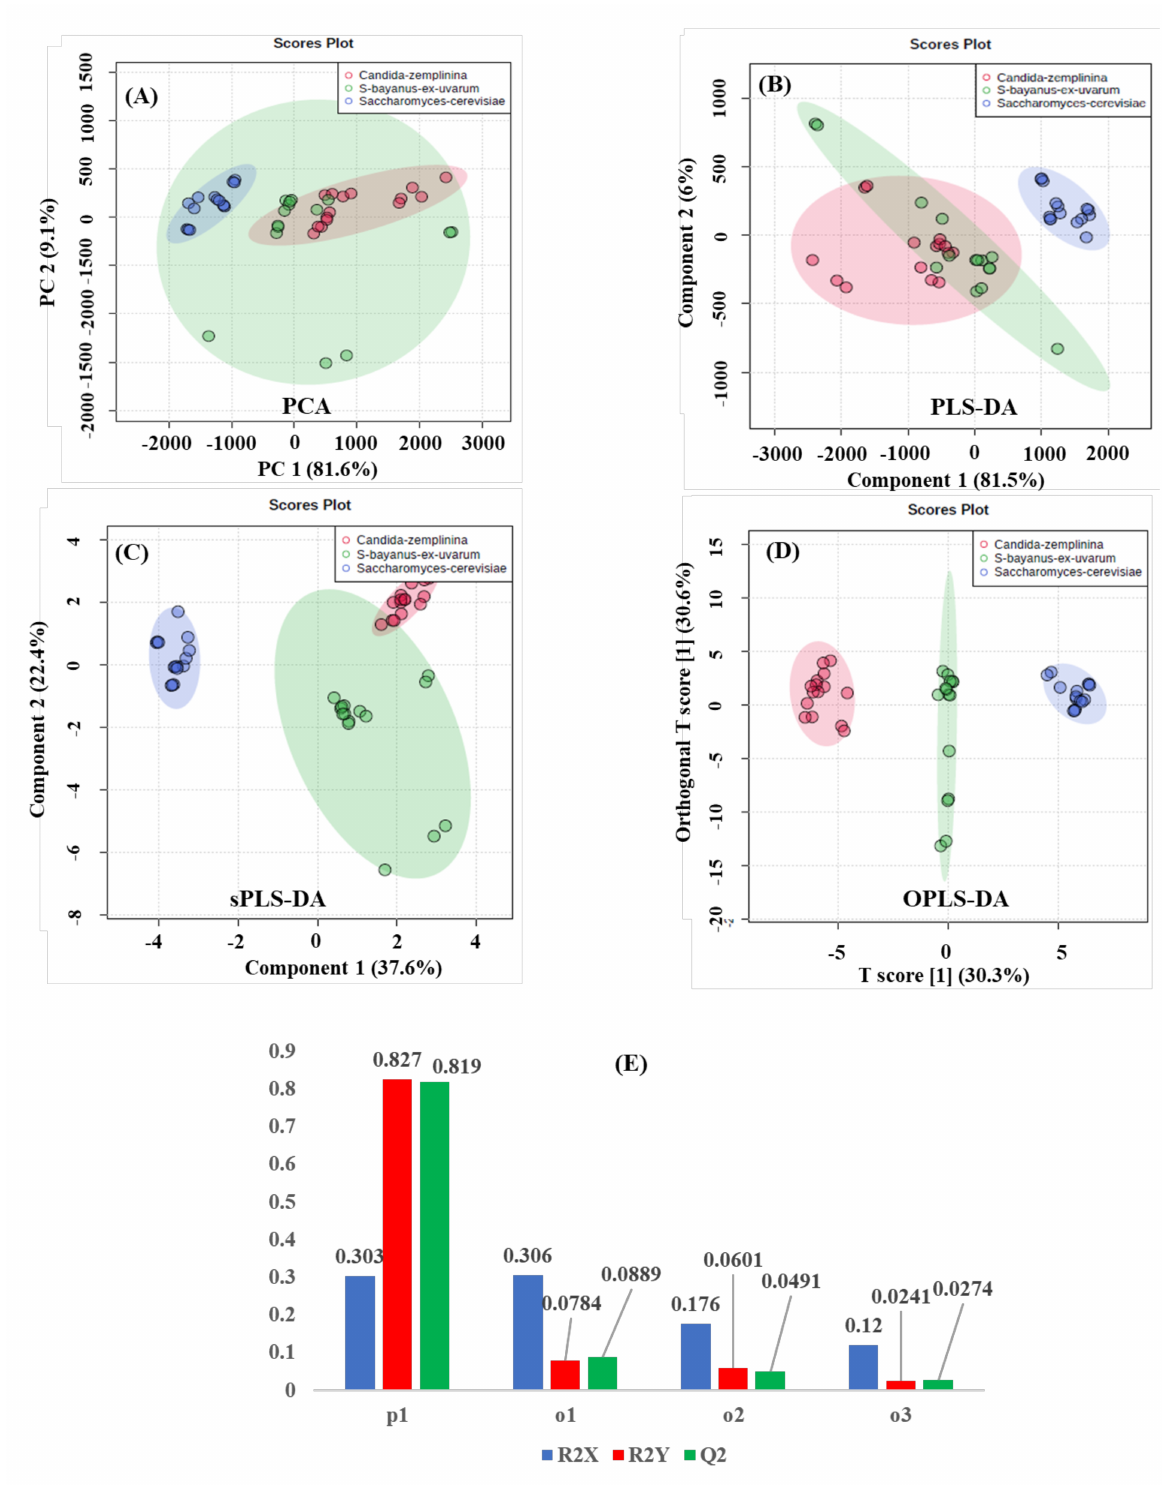
Figure 3. Unsupervised principal component ( A ) and supervised standard partial (PLS-DA) ( B ), sparse (sPLS-DA) ( C ) least square, and orthogonal projections to latent structures discriminant analysis (OPLS-DA) ( D ) score plots of Cabernet Sauvignon wines fermented with Saccharomyces cerevisiae (blue) , Candida zemplinina (red), and Saccharomyces bayanus ex uvarum (green) yeast strains, modeled from the DPFGE NMR data matrix (Figure S1). T2 Hotelling’s ellipses have a 95% confidence level in all cases. For PCA, PLS-, and sPLS-DA holistic fingerprints, the explained variances are highlighted in parentheses along the axis. ( E ) For OPLS-DA, the permutation analysis between one predictive (p1) and three orthogonal (o1, o2, and o3) components produced the observed and cross-validated R2X, R2Y, and Q2